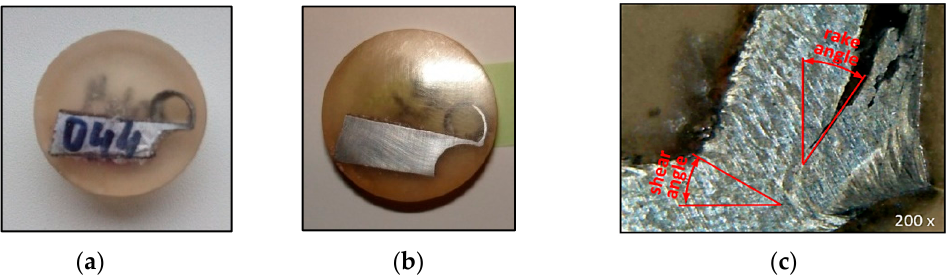
Figure 7. An example of investigated sample ( a ) before grinding, ( b ) after grinding and polishing, ( c ) shear and rake angle measuring. ( c ) shear and rake angle measuring. Metals 2019 , 9 , x FOR PEER REVIEW